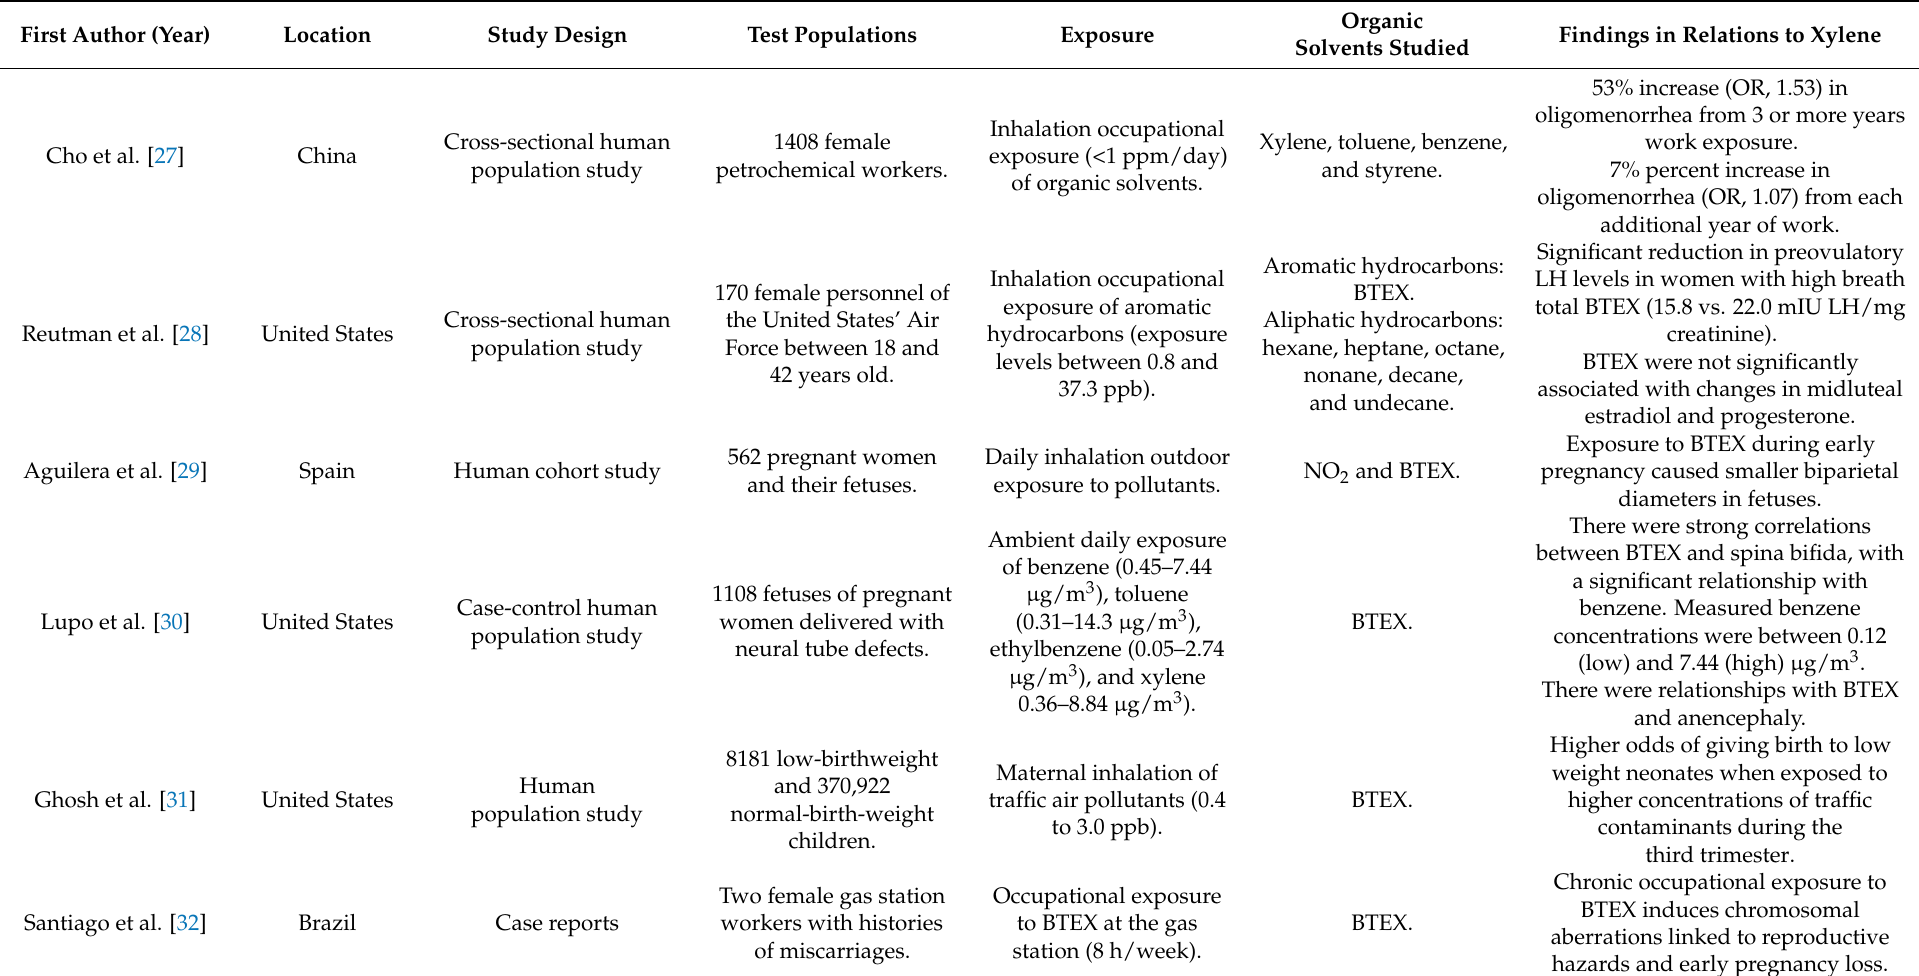
Table 6. Human studies on the toxicity of technical xylene to the female reproductive system from 1990 to